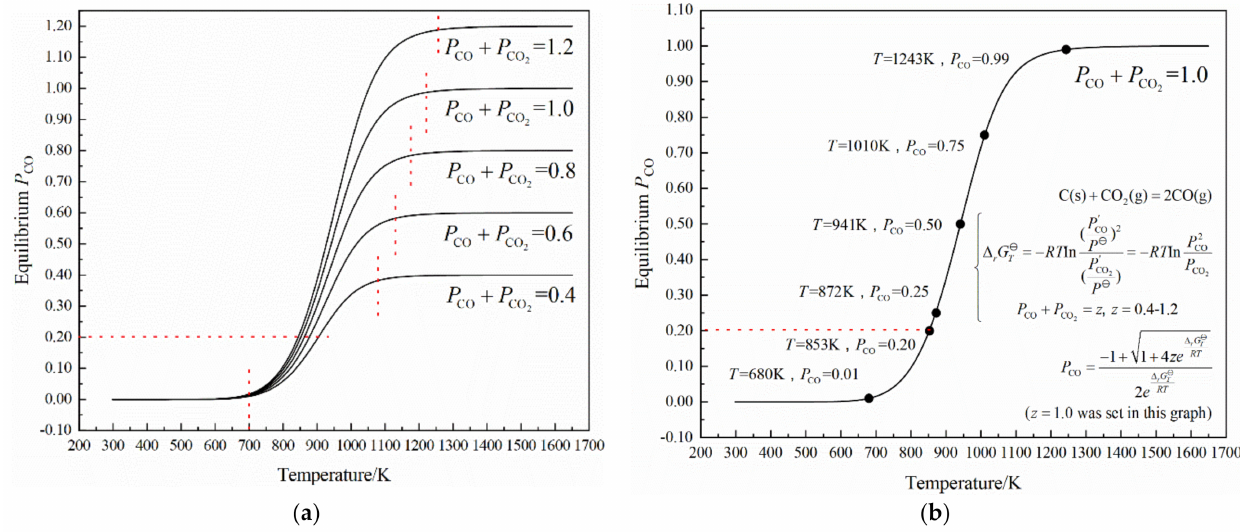
Figure 7. The equilibrium relative gas partial pressure of CO in the gasification reaction between carbon and CO 2 : ( a ) the sum value of relative gas partial pressure of CO and CO 2 was varied with 0.4, 0.6, 0.8, 1.0, 1.2; ( b ) the sum value of relative gas partial pressure of CO and CO 2 was